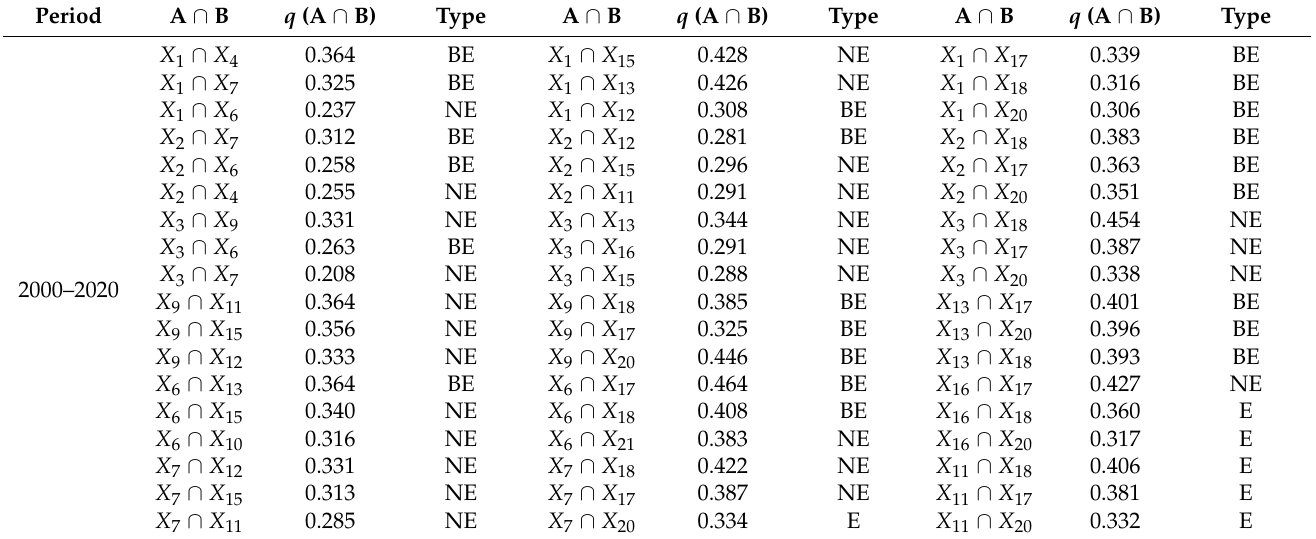
NE indicates non-linear enhancement, and BE indicates bi-factor